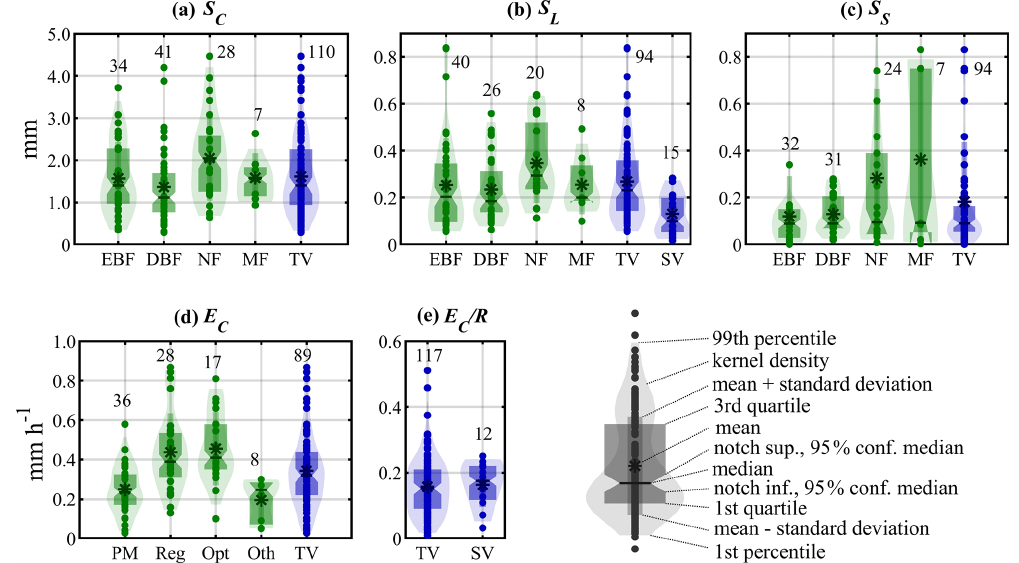
Figure 2. Violin plots of parameter statistics based on a meta-analysis of 183 field campaigns. (a–c) Parameters related to storage capacity, i.e. canopy storage capacity per unit of canopy area ( S C ), leaf area ( S L ) and stem storage capacity ( S S ). (d,e) Parameters related to evaporation, i.e. wet canopy evaporation rate ( E C ) and the ratio between wet canopy evaporation rate and rainfall rate ( E C /R) . Green bars are used for plant functional types, including evergreen broadleaf forests (EBF), deciduous broadleaf forests (DBF), evergreen needleleaf forests and deciduous needleleaf forests (NF) and mixed forests (MF). Blue bars represent the statistics for all tall vegetation (TV) and short vegetation (SV) plant functional types. The methods to obtain E C in (d) include the Penman–Monteith equation (PM), regression (Reg), optimisation (Opt) and other (Oth) methods. Labels with numbers represent the number of field